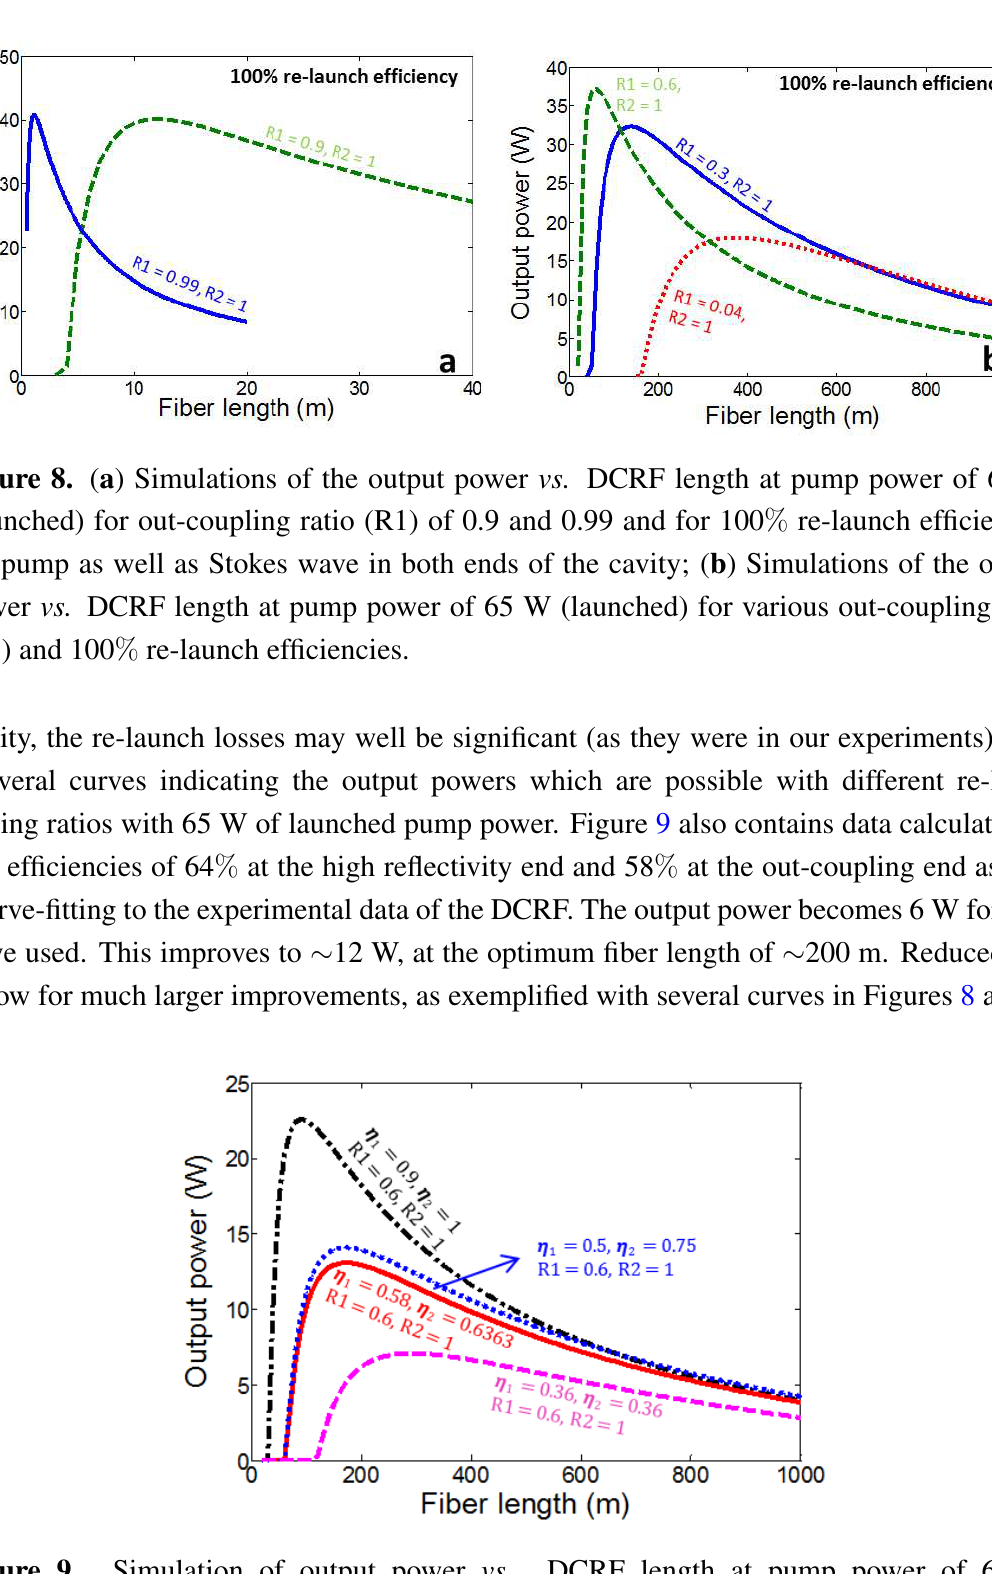
corresponds to high reflectivity end 2